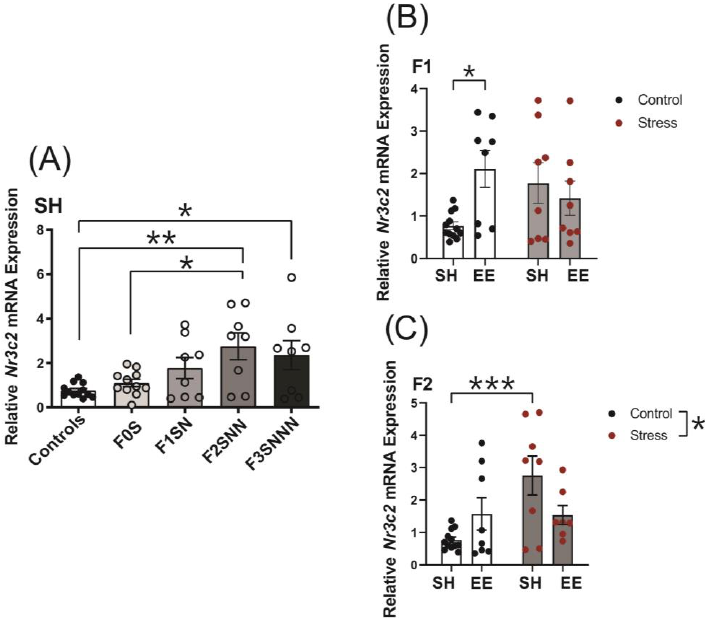
Figure 11 . Uterine gene expression analysis of Nr3c2 showed significant increases in stressed F2 and F3 dams under SH, with similar effects shown when raised under enrichment. ( A ) Nr3c2 mRNA levels across the F0 – F3 generations of stressed dams compared to controls. Analysis of Nr3c2 expression in the ( B ) F1 and ( C ) F2 generations of dams exposed to different treatments and housing types. Asterisks indicate significance: <0.05 (*); <0.002 (**); <0.001 (***). Data are compared to F0N, mean ± SEM. Ordinary one-way ANOVA ( A ) and two-way ANOVA ( B , C ) analyses were used. N = 8 – 12 ( A,B ) or 7 – 12 ( C ) per group. SH = standard housing; EE = enriched housing; F = filial generation; S = stressed; N = nonstressed.